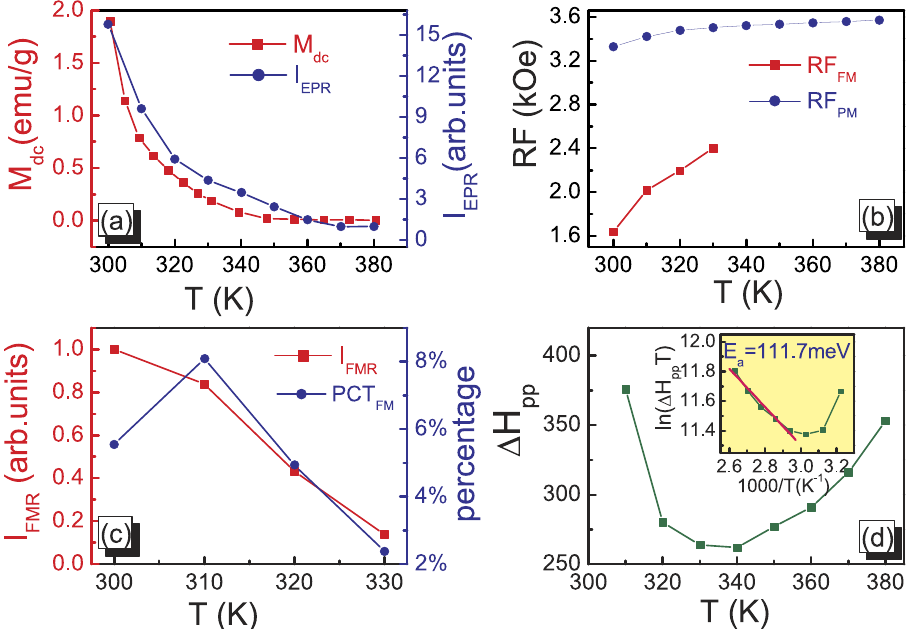
Figure 3. ( a ) EPR intensity I EPR versus T (solid circles) and M dc versus T (solid squares) at PM region. ( b ) Resonance field (RF) dependence of temperatures for PM and FM peak. ( c ) FM intensity (I FMR ) and FM fraction percentage (PCT FM ) dependence of temperatures. ( d ) EPR linewidth Δ H PP versus T ; inset represents the EPR linewidth plotted as Ln( Δ H PP T) versus 1000/T, (the solid line represents the fitting result with Eq.